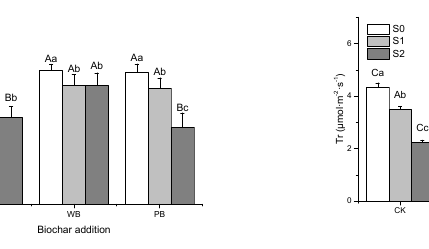
Figure 3. Photosynthetic rate (An), stomatal conductance (gs), and transpiration rate (Tr) as affected by biochar addition (B), drought stress (W), and salt stress (S). The treatments are biochar type (CK, WB, and PB), water supply (F and D), and salt condition (S0, S1, and S2). Different uppercase letters indicate significant differences at the 0.05 level among CK, WB, and PB treatments. Different lowercase letters indicate significant differences at the 0.05 level within groups.